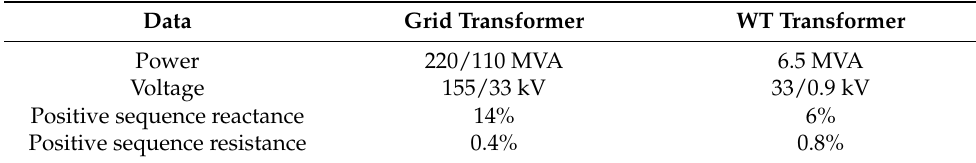
Table A4. Transformer data: 42-turbine wind power plant.